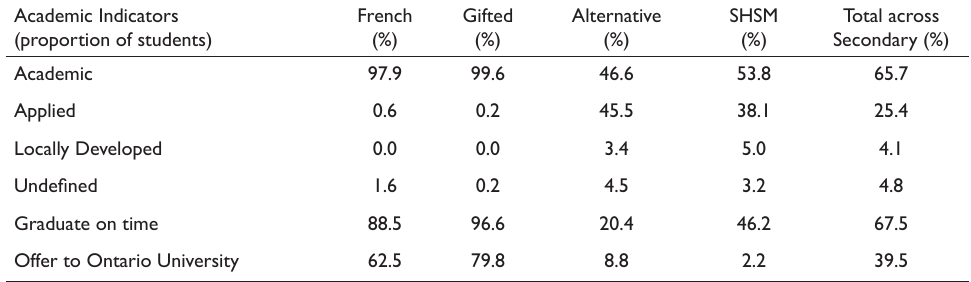
Table 1: AcademicindicatorsacrossprogrammesofchoiceintheTDSB,2011/12 4  AcademicIndicators (proportionofstudents)